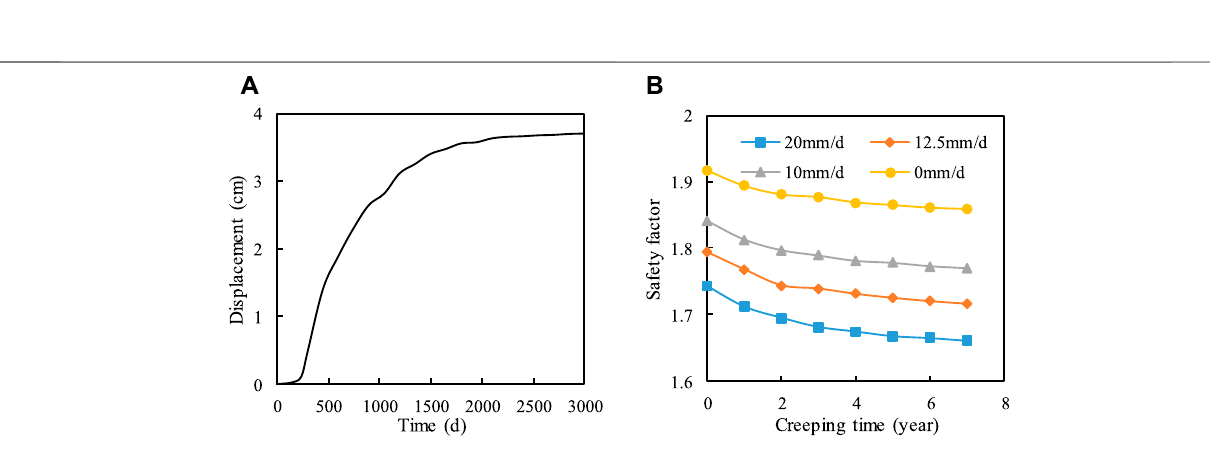
Frontiers in Earth Science |